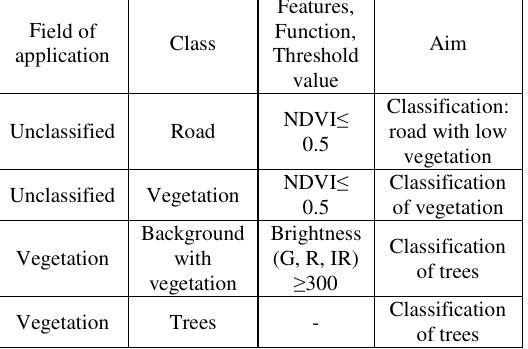
Table 5. Classification ruleset for plot number = 22.